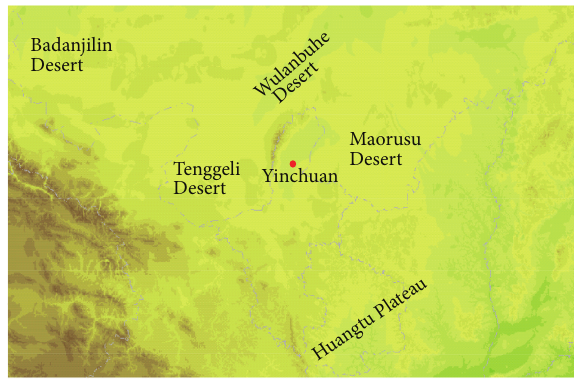
Figure 1: Map of the part of the northwest of China.